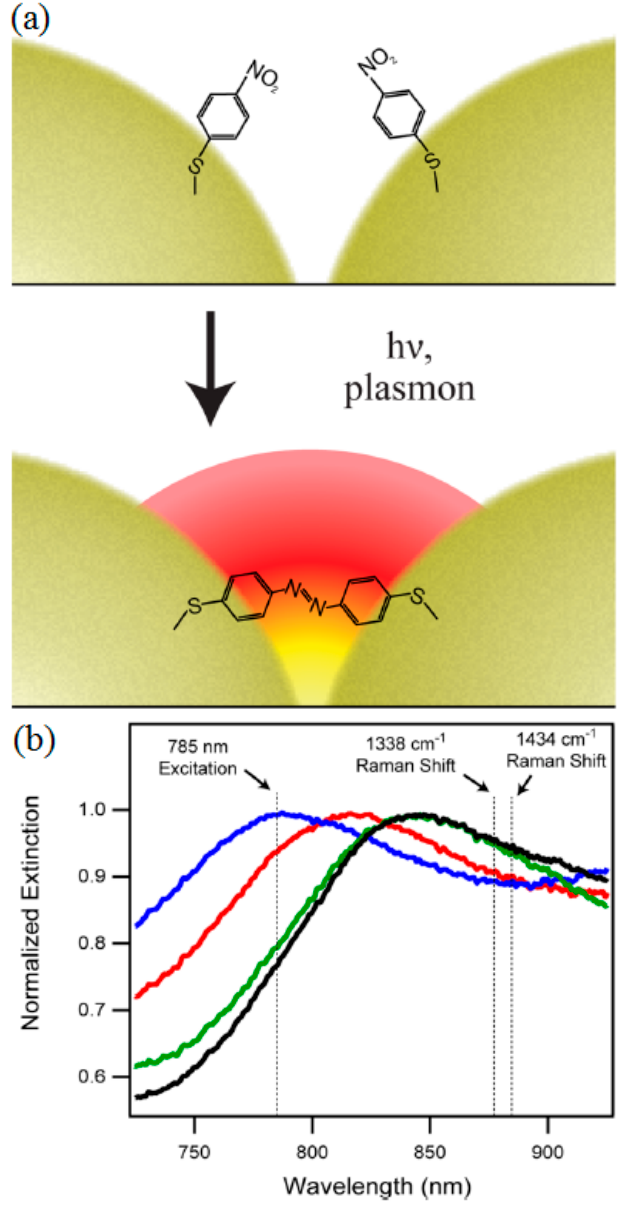
Figure 6. ( a ) Depiction of plasmon-driven conversion of 4NBT to DMAB; ( b ) localized surface plasmon (SP) measurements of SERS substrates. Different spots on the surface have varying plasmon-resonance wavelengths, affecting the SERS enhancement factor (EF) and electric-field enhancement [45].